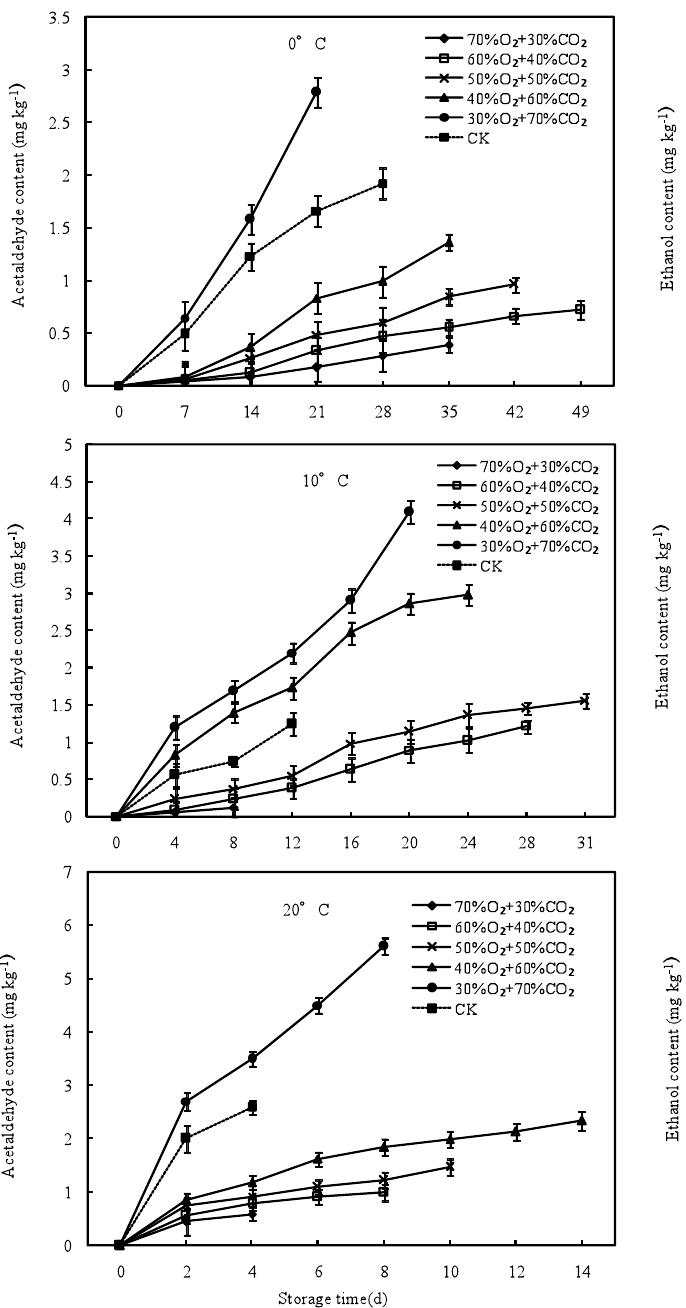
Fig. 4: Ethanol contents of broccoli heads treated with varying O 2 /CO 2 levels at different temperature. Vertical bars indicate the standard deviations for each treatment (n=5). Air treatment was used as